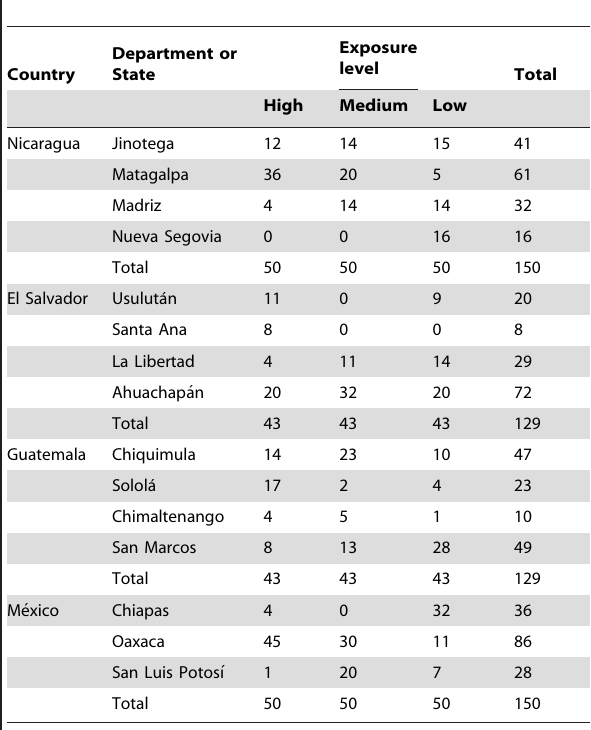
Table 1. Number of interviewed families by country and exposure level a